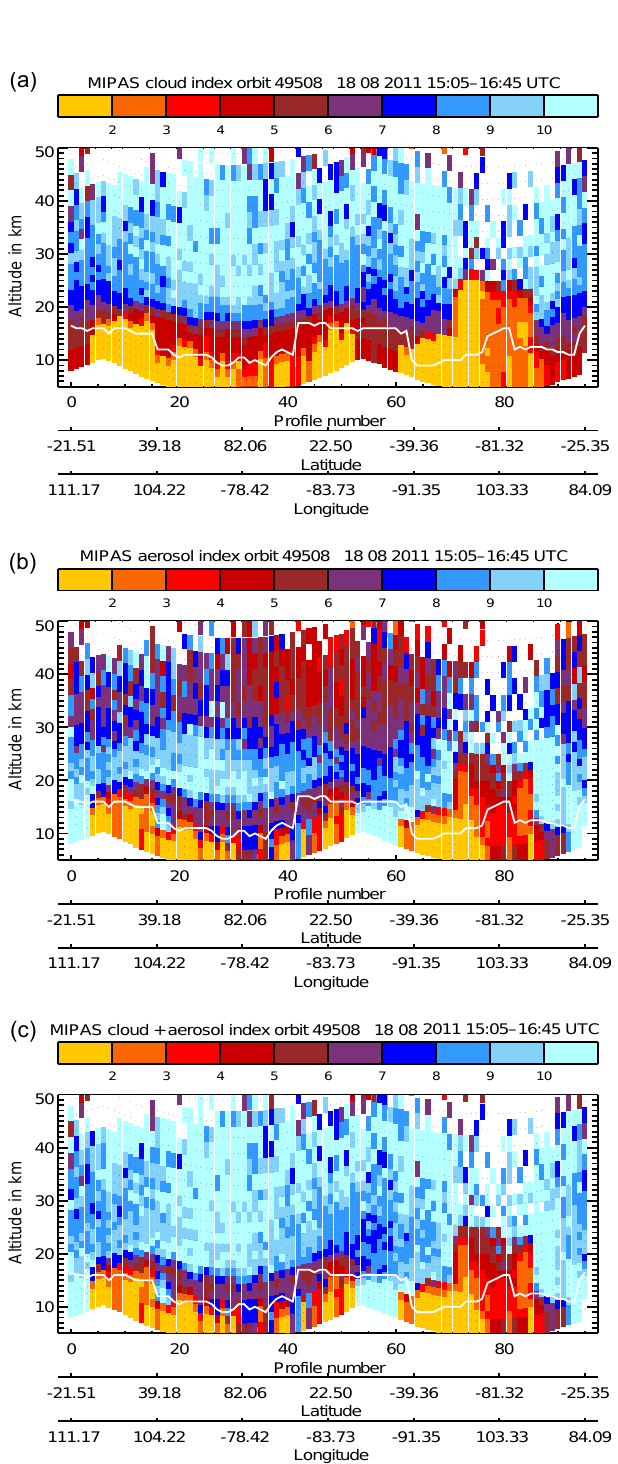
Figure A1. CI (a) , AI (b) , and ACI (c) up to 50km altitude for MIPAS orbit 49508 measured on 18 August 2011.